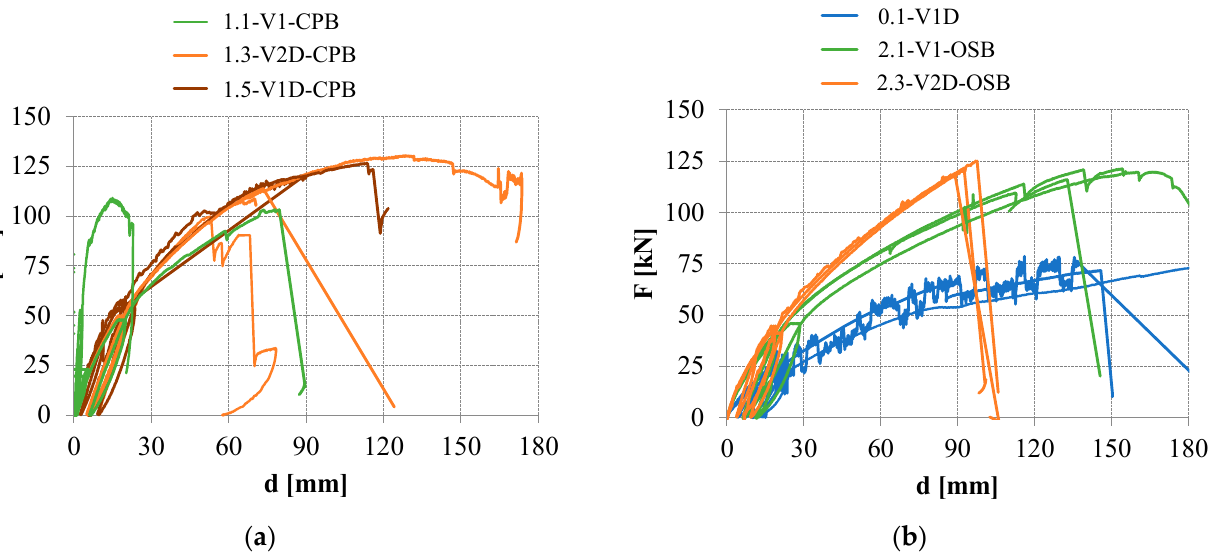
Figure 9. Diagrams of vertical forces obtained in dependence of the mid-span vertical displacements: ( a ) For beams with cement-particle boards; ( b ) For beams with OSBs and beams with no web panels. Table 2. Results of experimental bending tests. Beam Variation